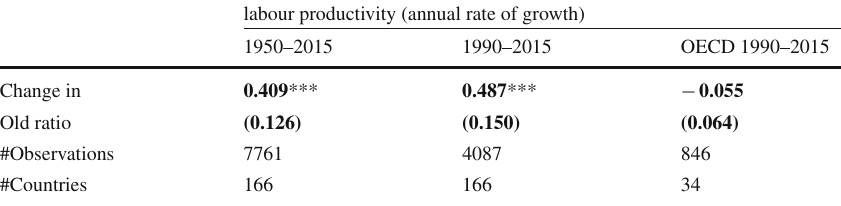
Table 3 Population ageing and labour productivity growth labour productivity (annual rate of growth)